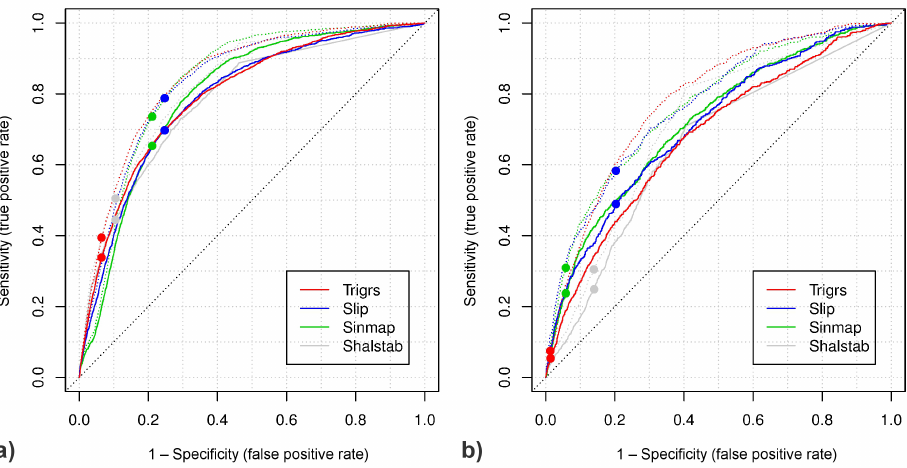
Fig. 8. ROC curves derived for: (a) area 1 and (b) area 2. Dashed lines represent the results of analyses that did not consider landslides of type (c) , whereas colored dots represent the positions along curves where FS = 1 for TRIGRS and SLIP, SI = 1 for SINMAP and critical rainfall is equal to 100mmday − 1 for